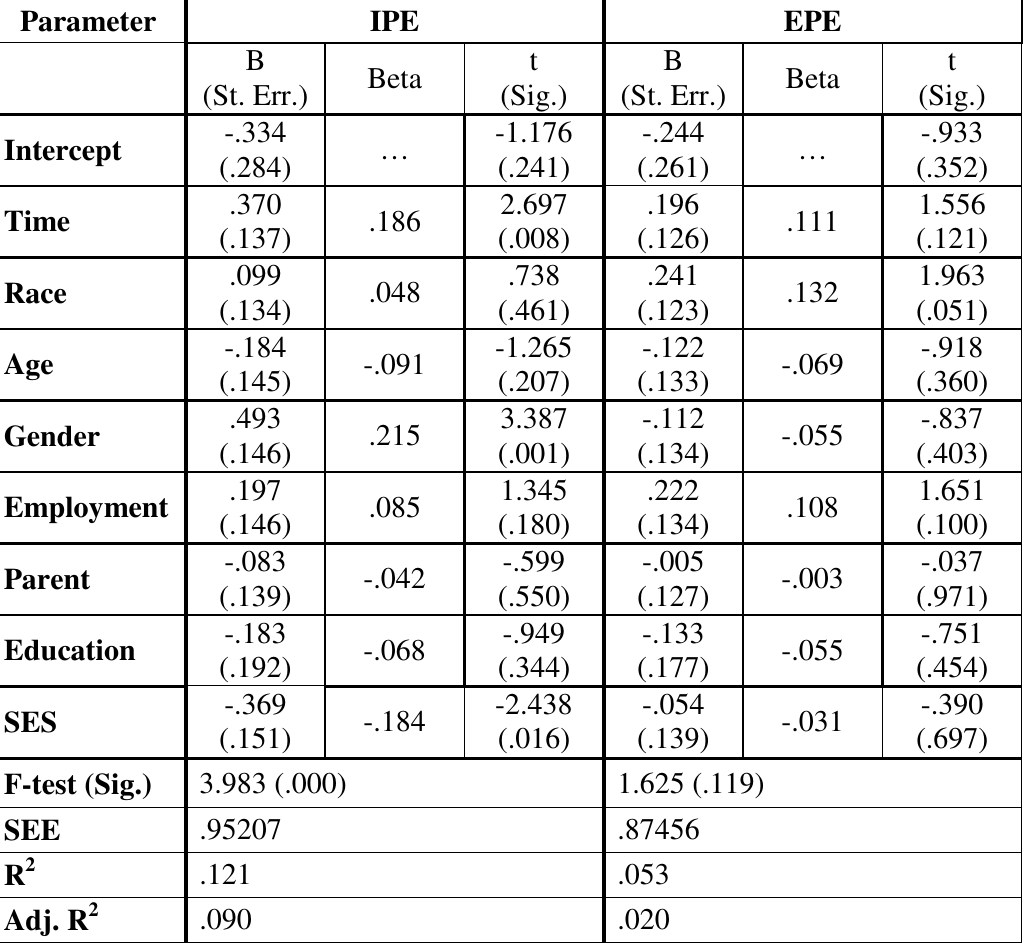
Table 9: OLS Results - IPE and EPE among Participants at Time 1 and Time